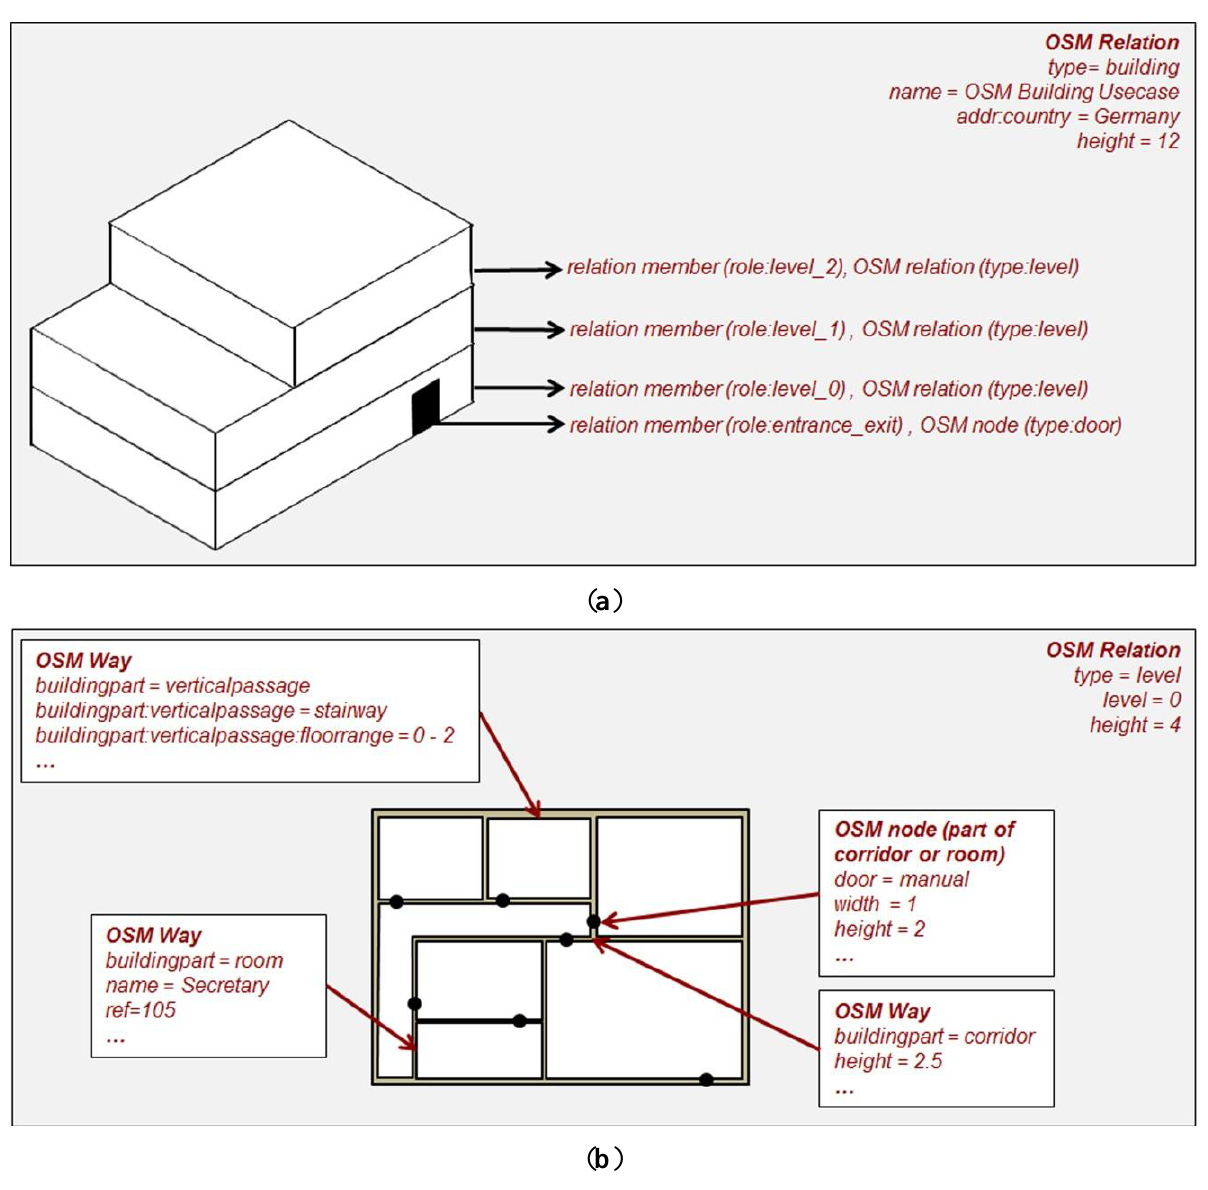
Figure 1. The basic hierarchical principle of a complete building ( a ) and the detailed floorplan information for an exemplary building floor/level ( b ) in IndoorOSM